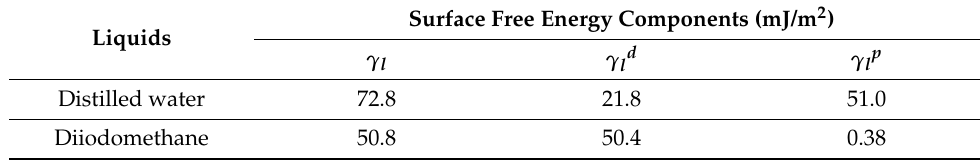
Table 1. Values of the total surface free energy( γ l ), dispersive component( γ ld ), and polar component ( γ lp ) of test liquid for PP/lubricant composites.